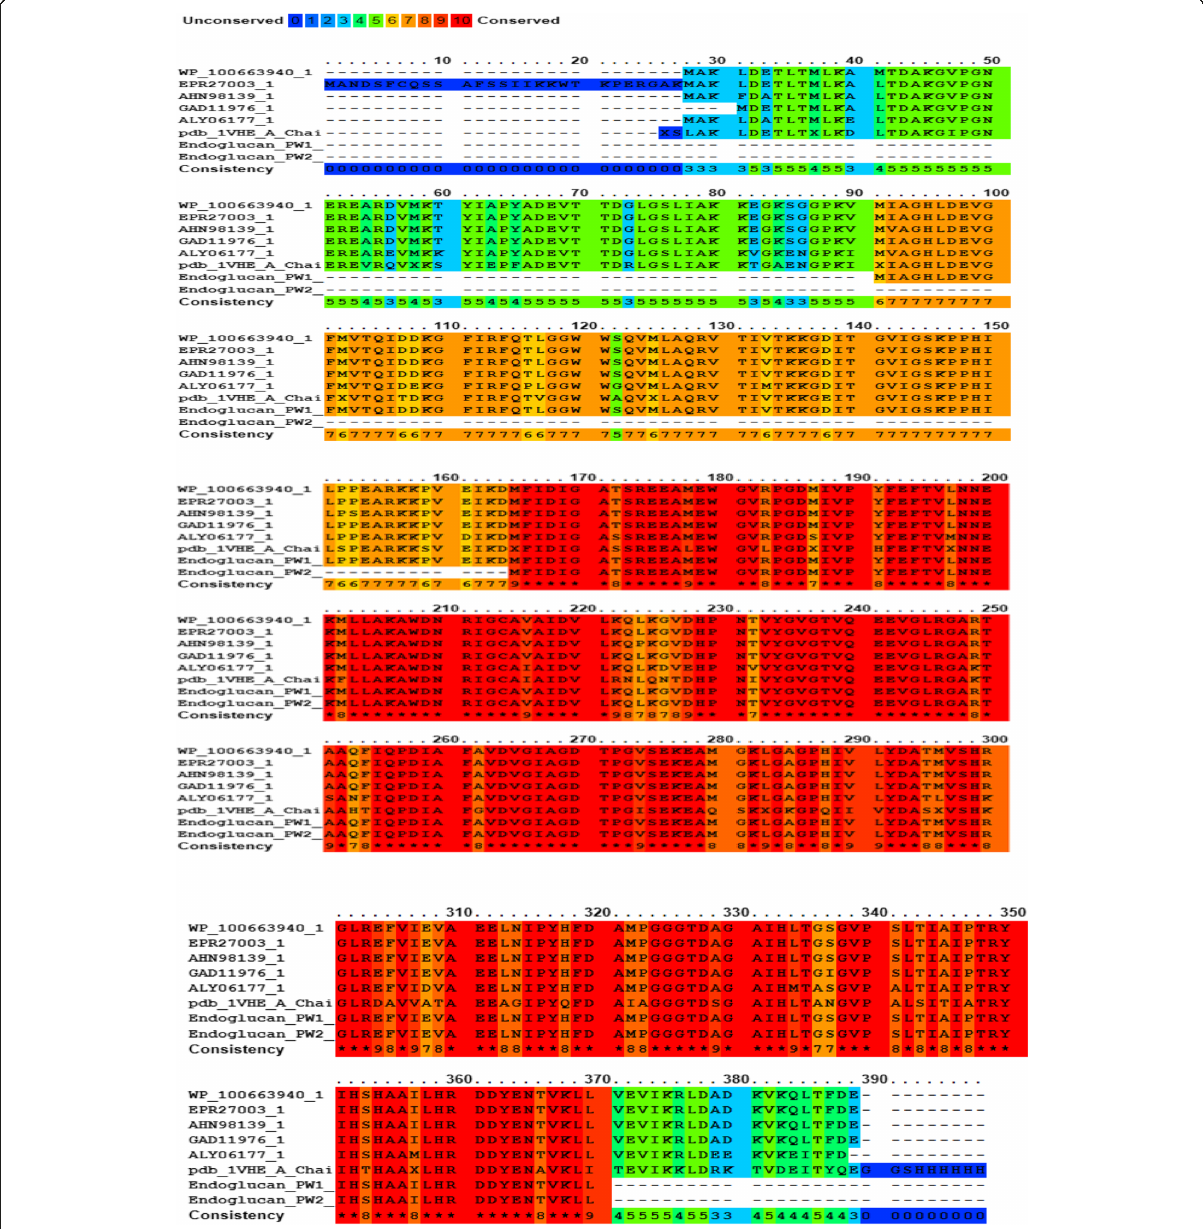
Fig. 3 Sequence alignment of PW1 and PW2 endoglucanases with representative members of endoglucanases, cellulases, and aminopeptidase proteins. The protein sequences corresponding to M42 family peptidase of Geobacillus sp. WSUCF-018B (WP_100663940.1), endoglucanase M of Geobacillus sp. WSUCF1 (EPR27003.1), cellulase of thermophilic bacterium enrichment culture clone XM70 (AHN98139.1), cellulase of Geobacillus kaustophilus (GAD11976.1), cellulase of Bacillaceae thermophilic enrichment clone (ALY06177.1), aminopeptidase/glucanase homolog of Bacillus subtilis strain168 (pdb_1VHE.A Chain A), endoglucanase PW1 ( Bacillus sp. PW1), and endoglucanase PW2 ( Bacillus sp. PW2) were selected, and alignment was performed using PRALINE. The conservation scale is shown on the